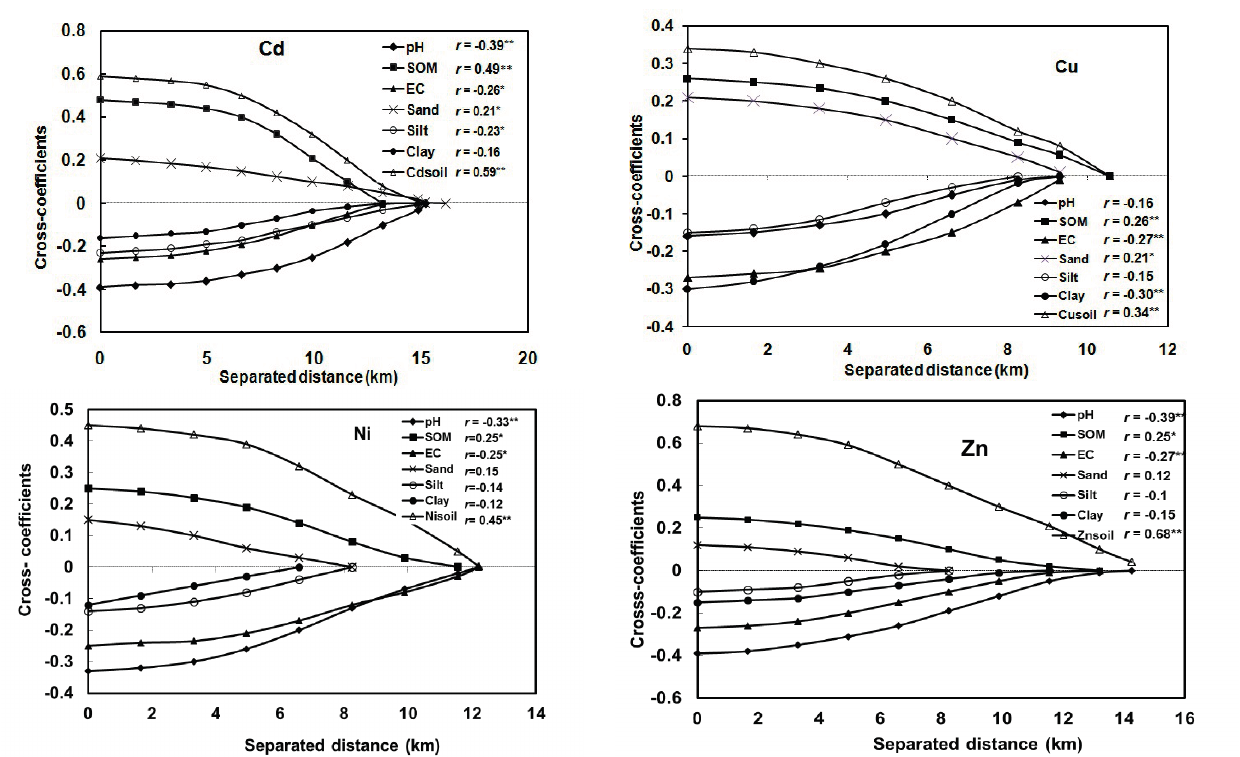
Figure 6. Cross-correlograms for each heavy metal between heavy metal in rice and soil properties, total heavy metal in soil. ( ** Correlation is significant at the 0.01 level; * correlation is significant at the 0.05